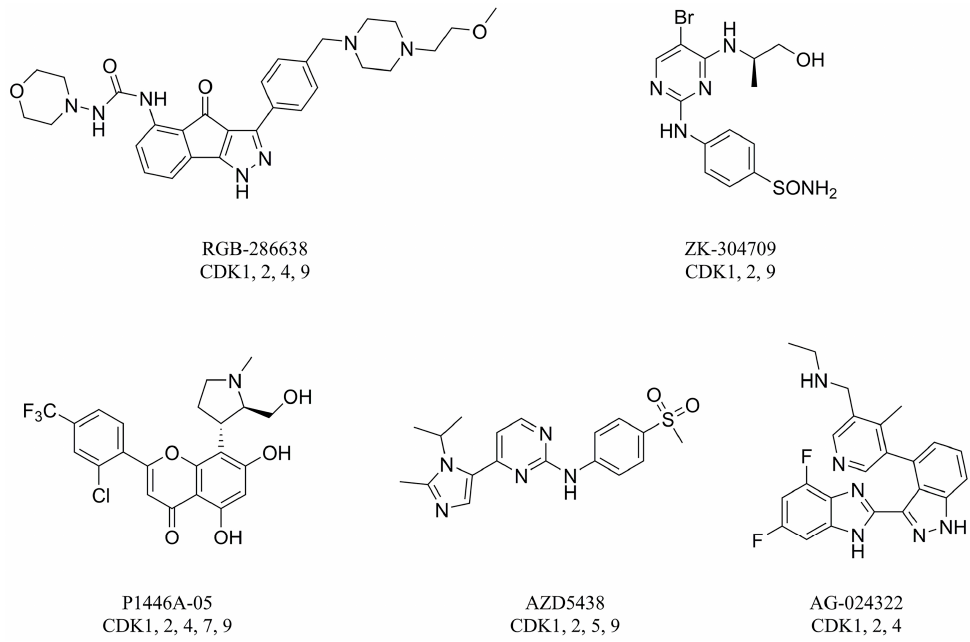
Figure 1. Structures of RGB-286638, ZK-304709, P1446A-05, AZD5438, and AG-024322.